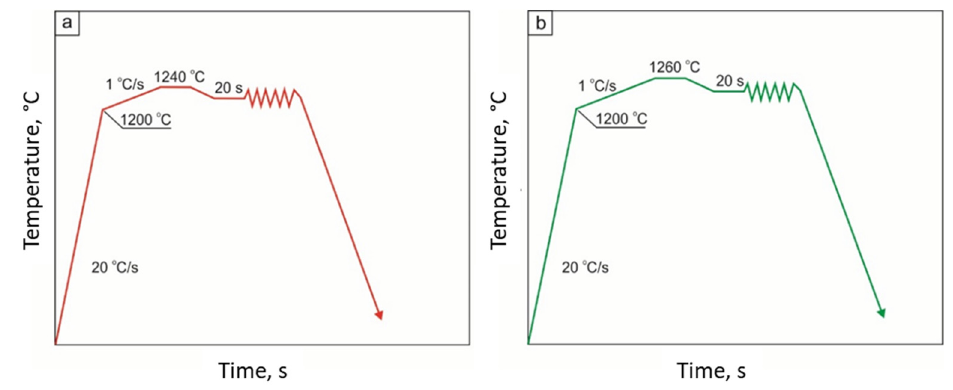
Figure 3. Scheme of determining the ductility recovery temperature (DRT) in 27Mn-4Si-2Al-Nb steel ( a ) and in 24Mn-3Si-1.5Al-Nb-Ti steel ( b ).